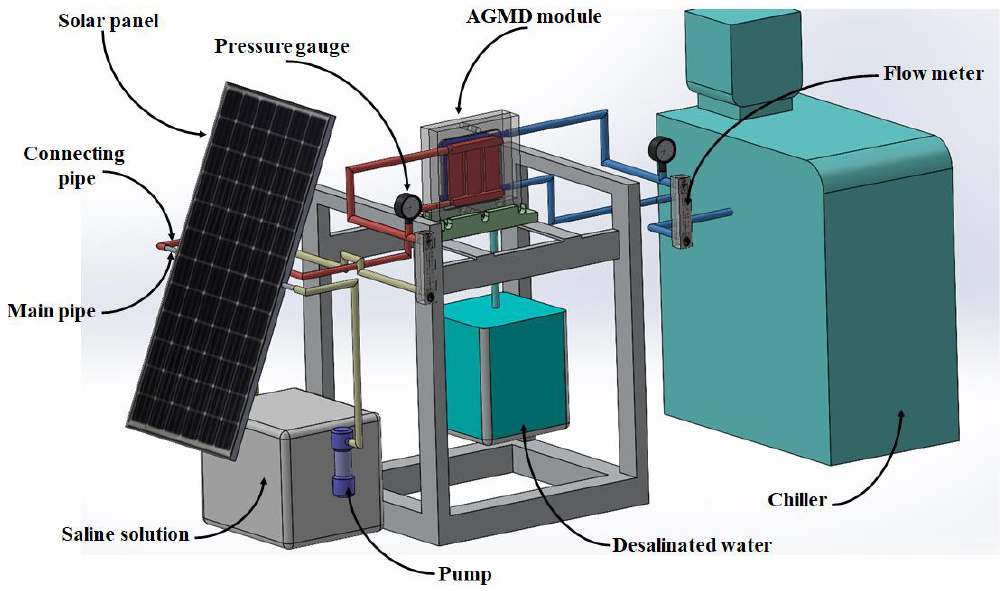
Figure 1. Proposed system.